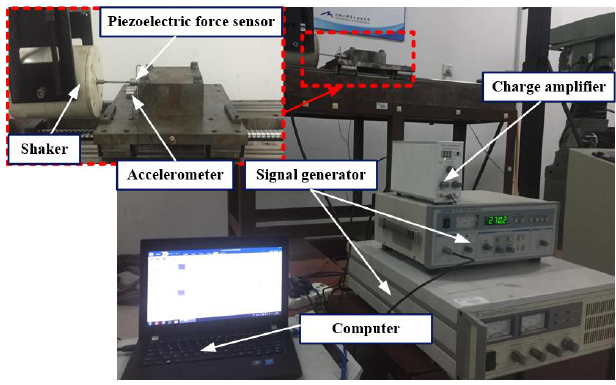
Figure 7. Vibration experimental device of ball screw feed system.